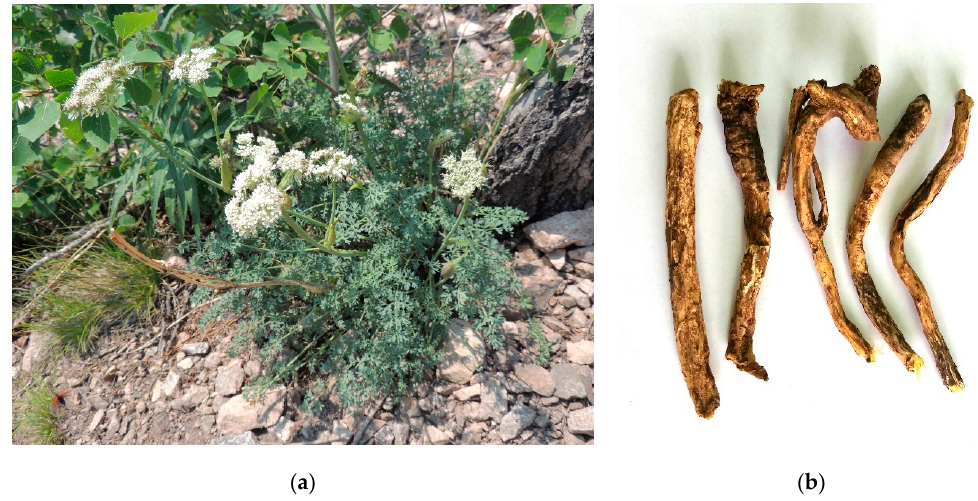
Figure 1. Phlojodicarpus sibiricus (Fisch.) Koso-Pol. plant in nature habitat ( a ); Siberia, Buryatia Republic) and its roots ( b ).